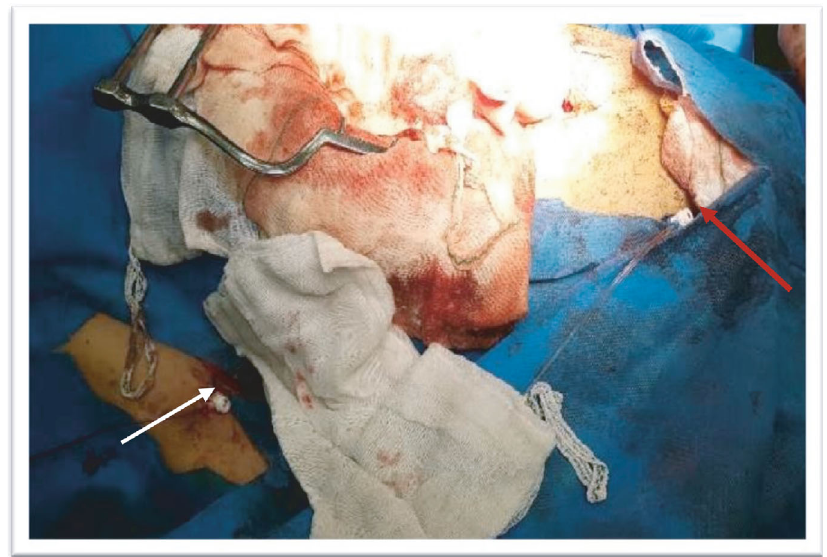
Figure 4: Intraoperative photography of the brachial sheath (white arrow) and femoral sheath (red arrow) used for brachiofemoral shunt during the